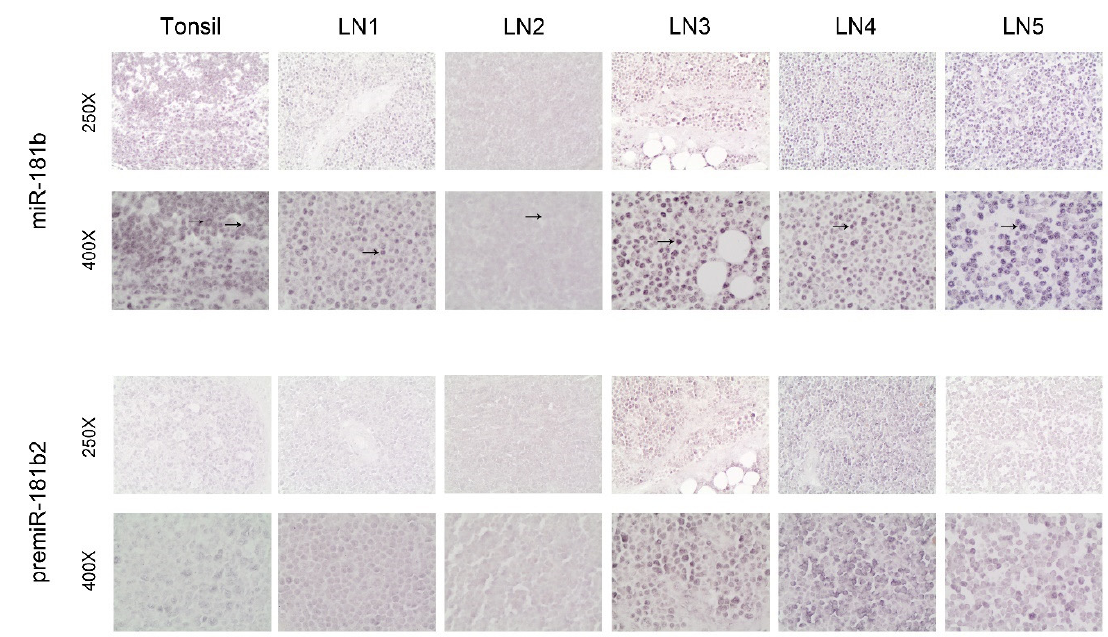
Figure 4. In situ hybridization of miR-181b and the respective pre-miRNA on tissue sections from tonsil of non-cancer patients and from lymph nodes of CLL patients. One representative picture of a tissue section of tonsil is shown (upper left) and lymph node sections from 5 CLL patients at 250X and 400X magnifications. Bold arrows indicate the nuclear localization, while slim arrows the cytoplasmic localization.